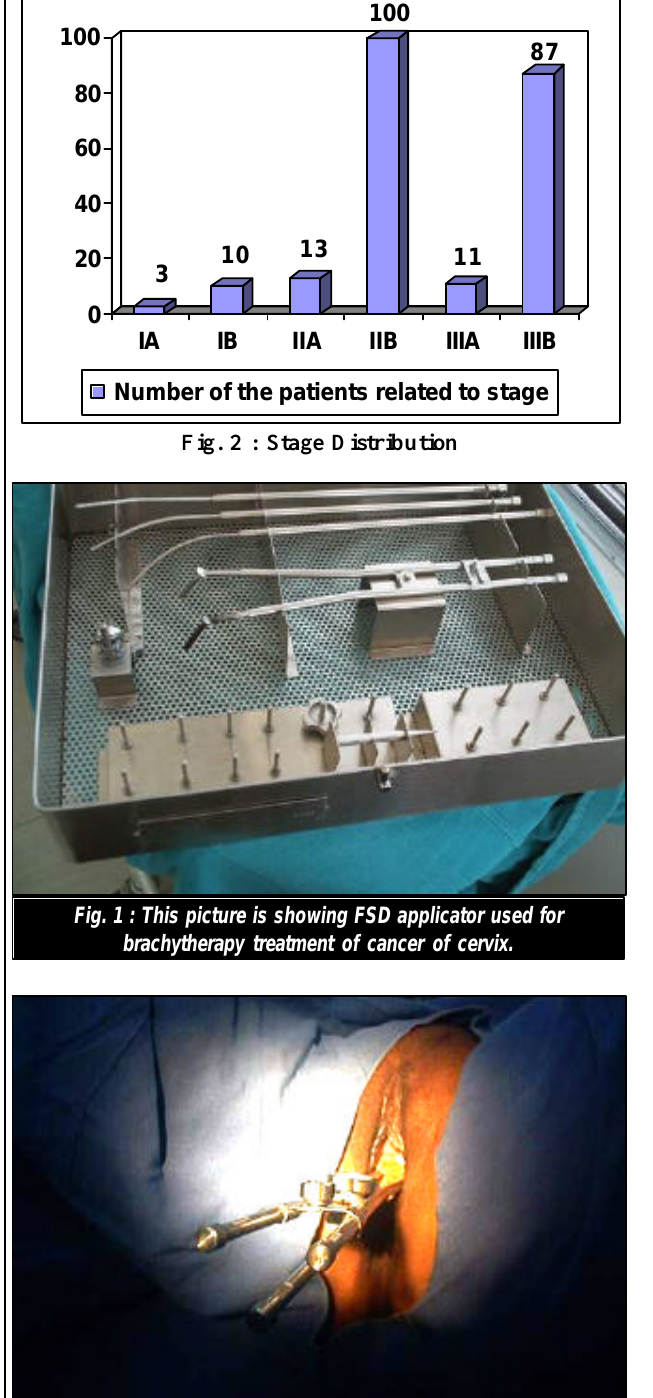
Fig. 2 : This picture is showing FSD applicator inserted and with the packing.